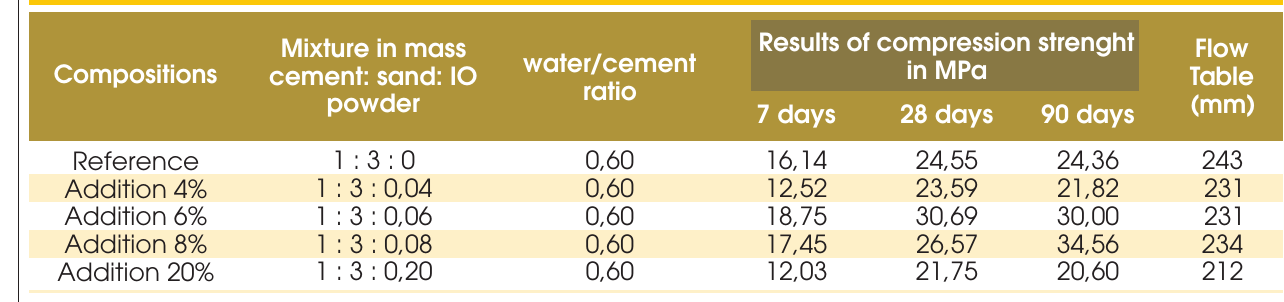
Table 1 – Compression strenght, w/c ratio and consistency index of additions and the reference